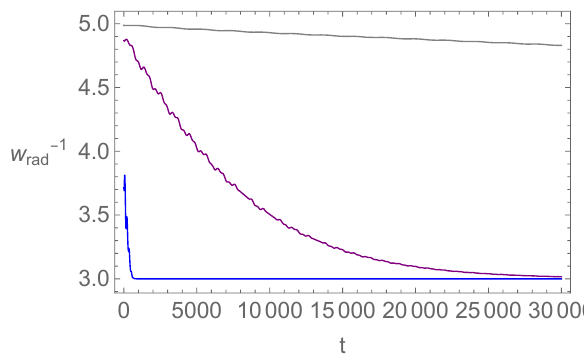
for various values of σ in the case of β ( t = 0) = 100 . The Figure 13. Time evolution of w − 1 ∗ rad parameter is chosen from the bottom to the top as σ = 8 . 3 (blue), 10.6 (purple), 12.9 (gray) which ∗ correspond to b = 31 . 7 , 100, 316, respectively. The other parameters are chosen as vac